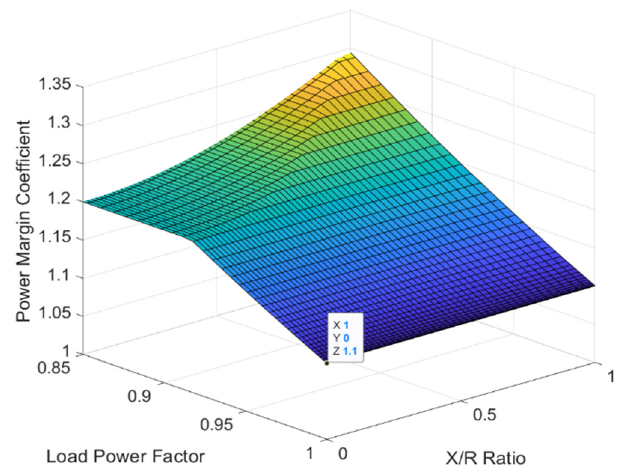
Figure 5. Power margin coefficient for conversion method with conductors switching.